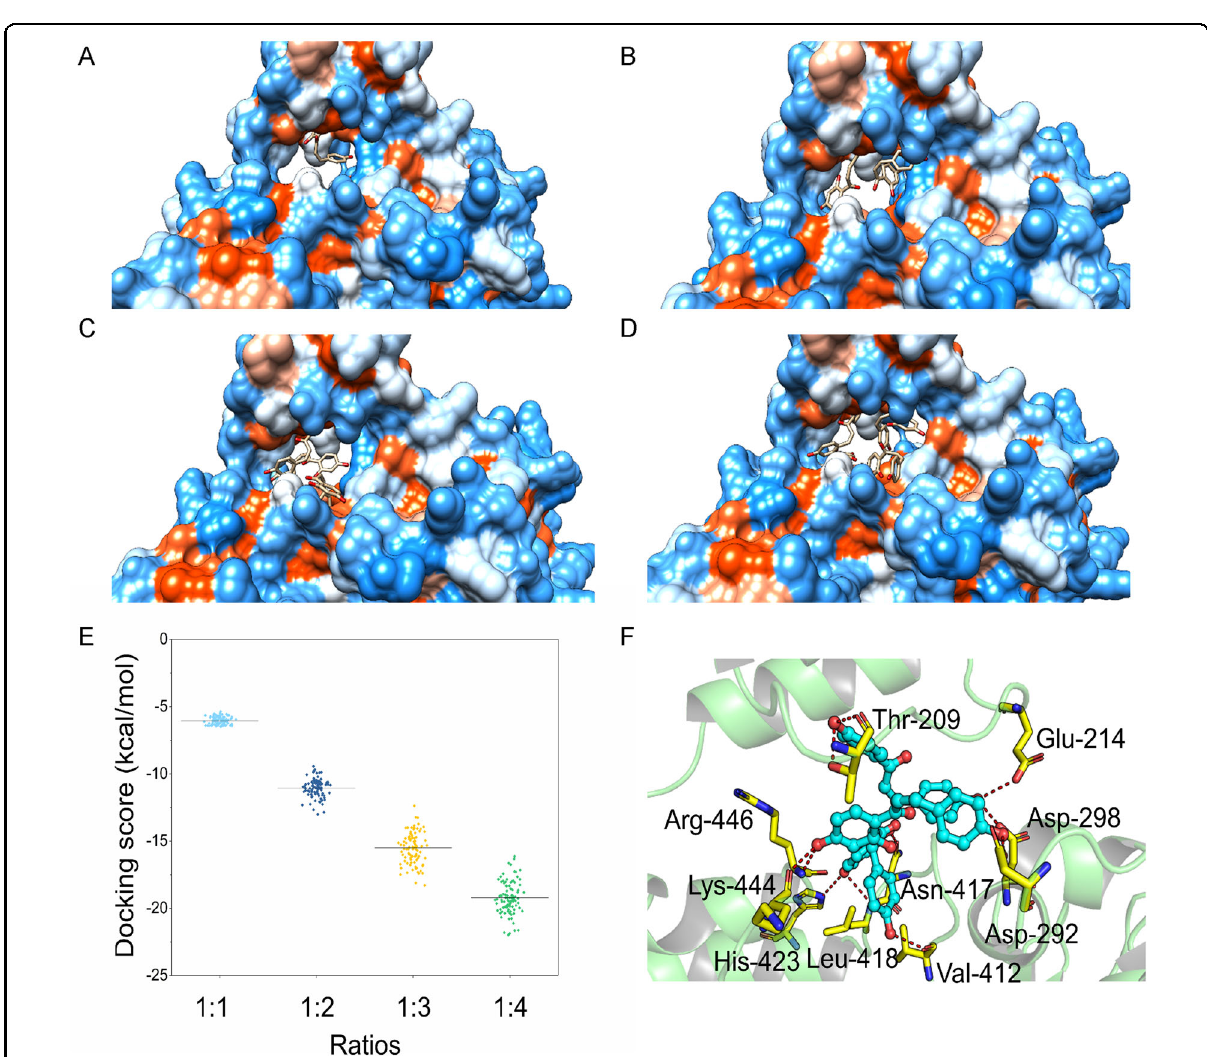
Fig. 5 The binding mode between SIRT1 and ISL. Binding mode analysis between ISL and SIRT1 with different ratios. a 1:1; b 1:2; c 1:3; d 1:4. e The docking score distributions for each ratio. f A detailed view of SIRT1: ISL at a binding ratio of